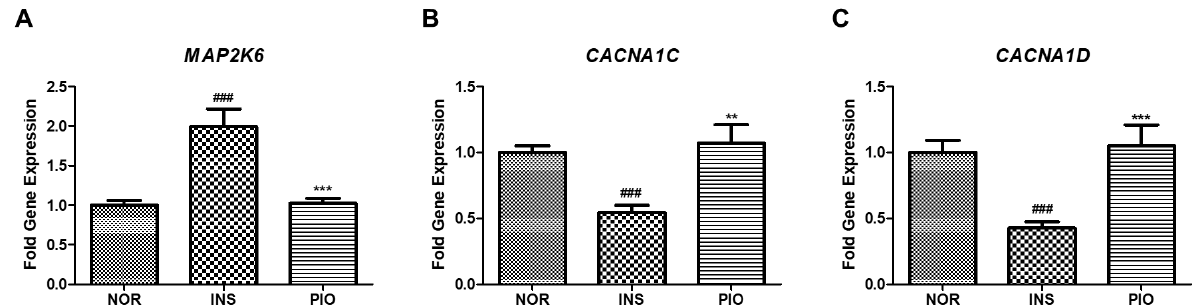
Figure 10. Differential gene expression induced by insulin-treated zebrafish. ( A ) The map2k6 gene was determined by RT-qPCR. (###) p < 0.001; compared to normal group (NOR). (***) p < 0.001; compared to insulin-treated group (INS). ( B ) The cacna1c gene was determined by RT-qPCR. (###) p < 0.001; compared to normal group (NOR). (**) p < 0.01; compared to insulin-treated group (INS). ( C ) The cacna1d gene was determined by RT-qPCR. (###) p < 0.001; compared to normal group (NOR). (***) p < 0.001; compared to insulin-treated group (INS).